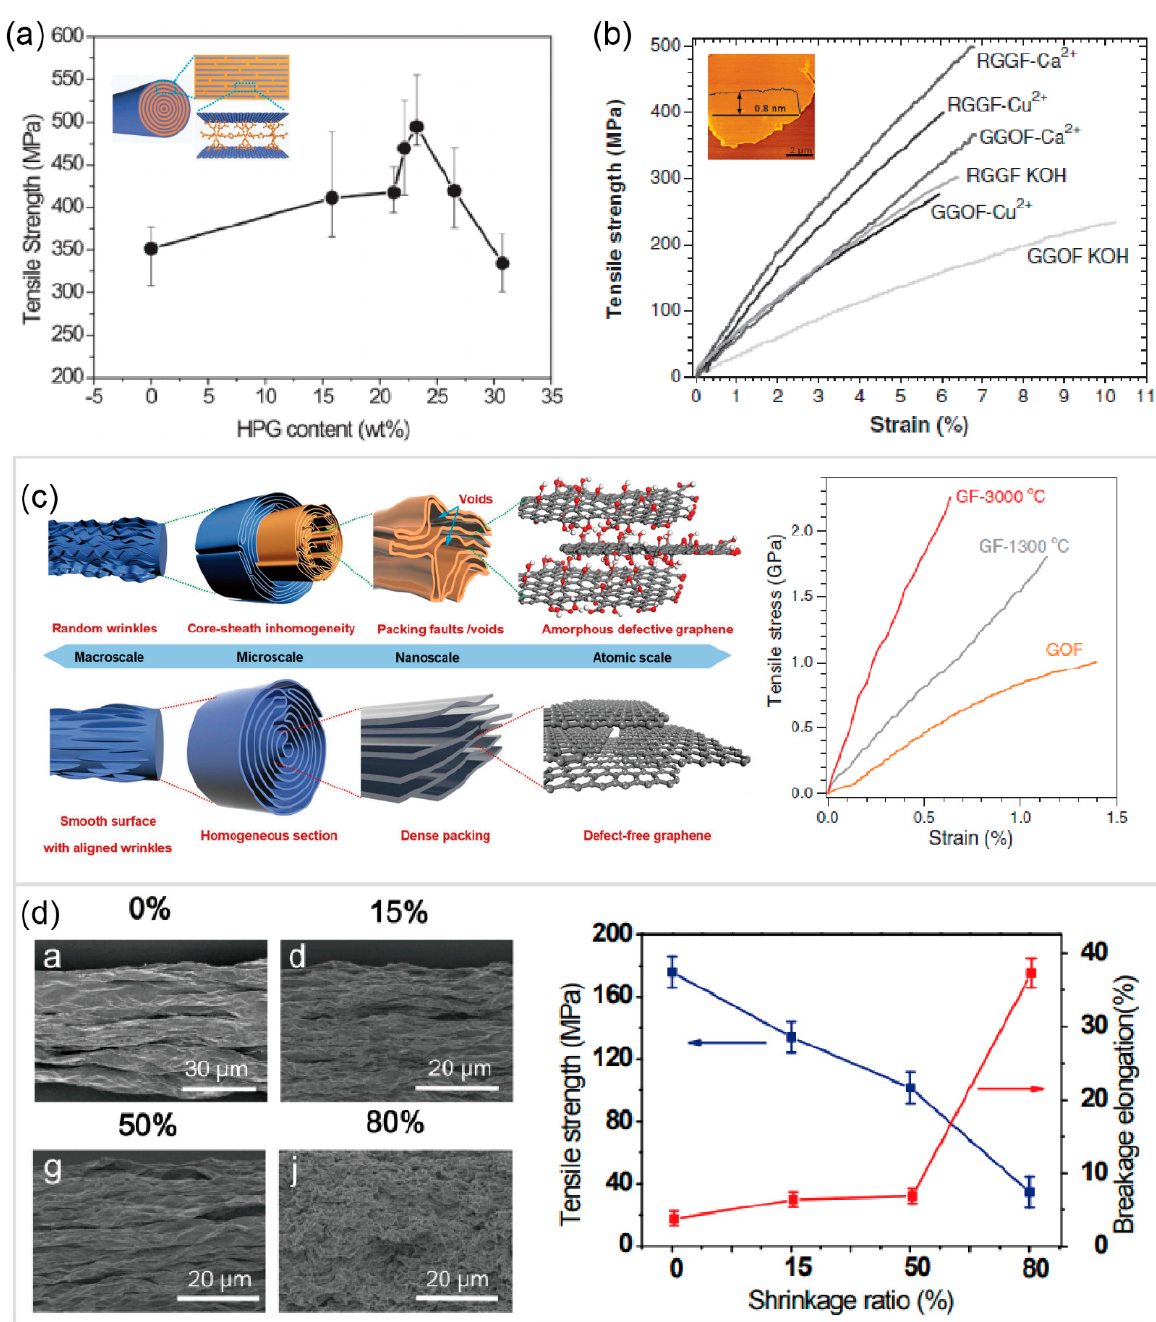
Figure 10. Graphene fibers (GFs). ( a ) Improved tensile strength for GFs with introduced polymers among adjacent sheets. Reprinted with permission from [132]. ( b ) Tensile stress curves for GFs with giant graphene sheets and different crosslinks. Reprinted with permission from [9]. ( c ) Schematic plot of full ‐ scale synergetic defect engineering to manage possible defects of GFs from the atomic scale to macroscale and tensile stress curves of resultant GFs. Reprinted with permission from [133]. ( d ) Surface morphologies of shrunk GFs fabricated by dry ‐ spinning method and corresponding strength and break elongation. Reprinted with permission from [129].